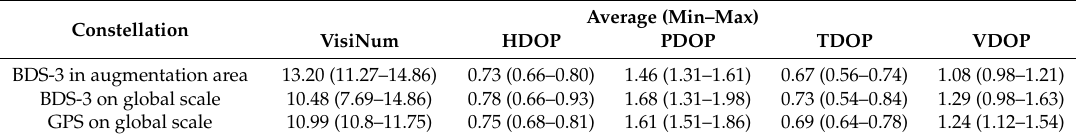
Table 3. The average, minimal, and maximal visible satellites and DOPs of BDS-3 and GPS.